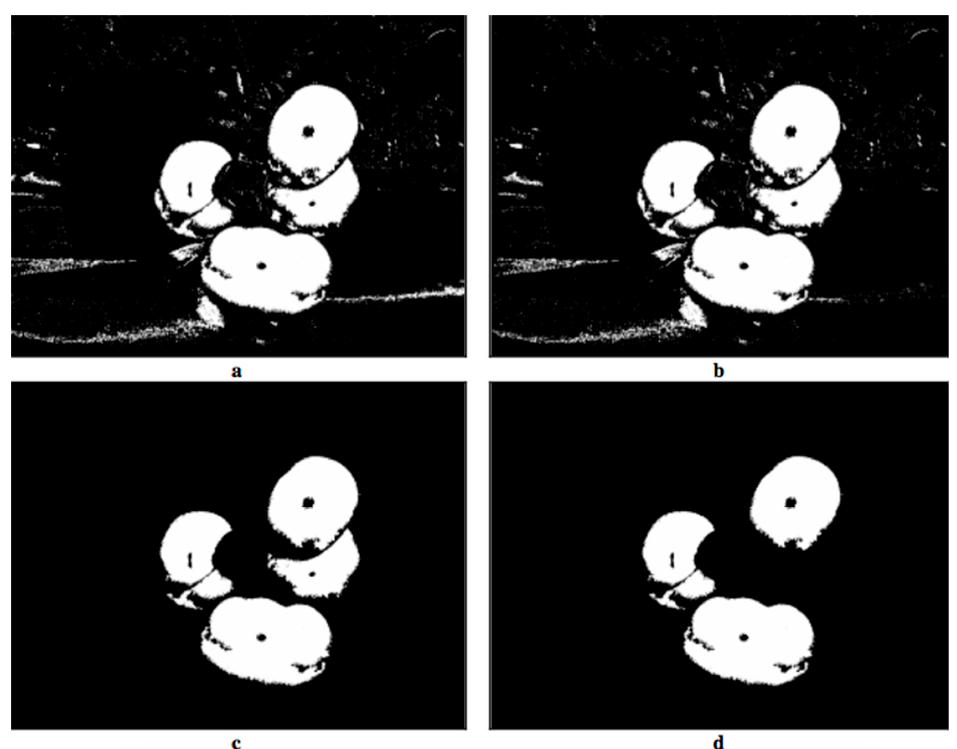
Figure 13. ( a ) Figure 12b; ( b ) edge removal of image objects; ( c ) segmentation based on size 1; and ( d ) segmentation based on size 2.